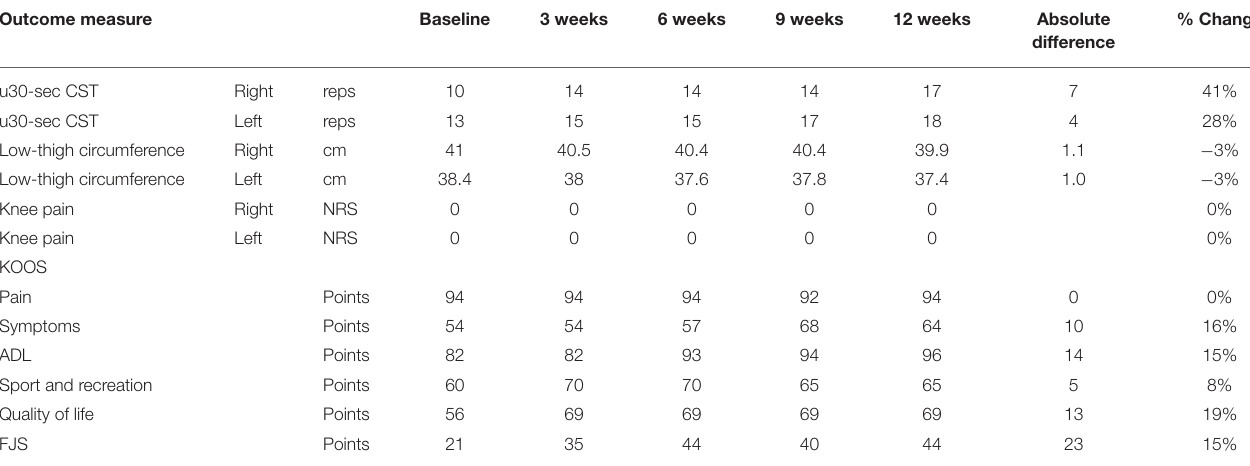
TABLE 2 | Outcome measure from baseline to after 12 weeks of BFR-RT. Outcome measure